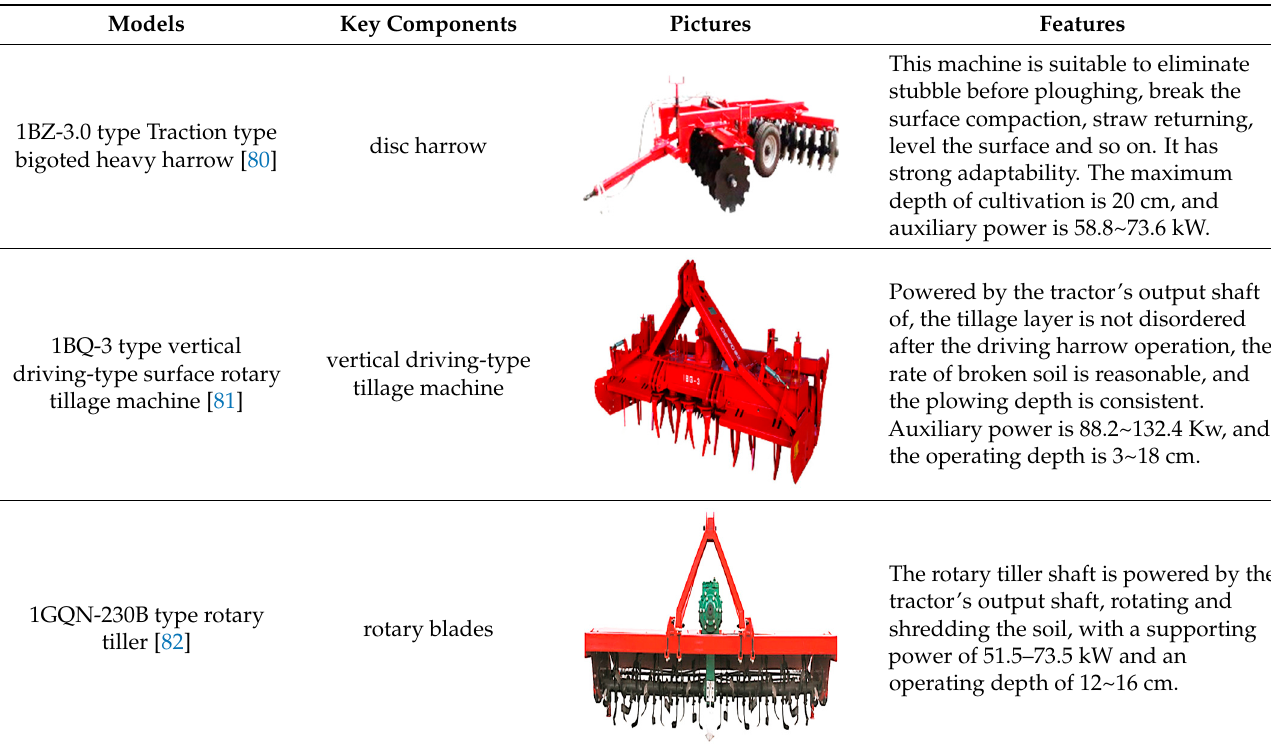
Table 5. Typical machines for topsoil tillage .